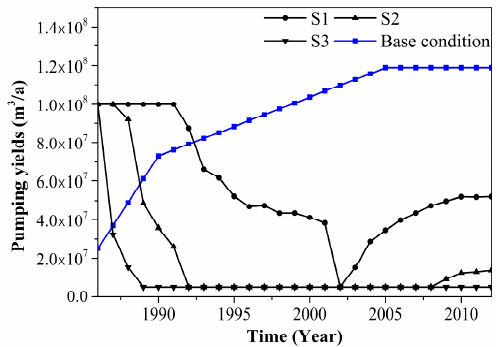
Figure 6. The optimized pumping yields for S1, S2, and S3 and the base condition (the pumping yields from the collected data) of the Daman irrigation district.